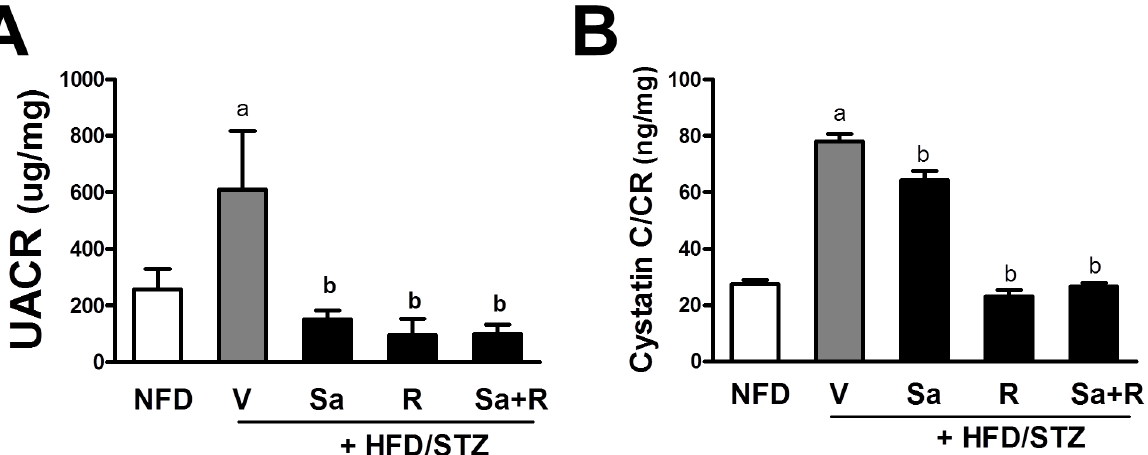
Fig 2. Effects of sarpogrelate (Sa) and rosuvastatin (R) on HFD/STZ-induced renal function. (A) At Week 20 of the HFD, urine samples were collected overnight (15 h) for three consecutive days, and levels of urine albumin were determined in pooled urines. Albumin levels were normalized with corresponding urine creatinine levels to obtain the urine albumin-to-creatinine ratio (UACR) values. (B) Urine cystatin C levels were normalized with corresponding creatinine (CR) levels. The data are means ± SD from 3 pooled urine samples. a P < 0.05 compared with the NFD group. b P < 0.05 compared with the HFD/STZ